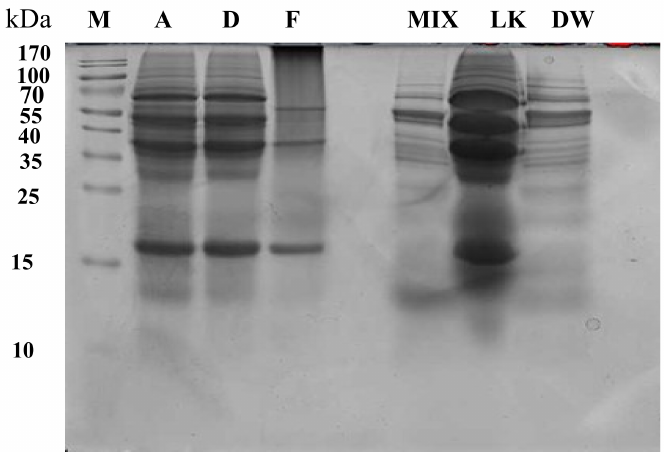
Figure 1. Reduced SDS-PAGE protein profile of lupin-enriched pasta samples and raw materials; M, pre-stained molecular marker; A, D, and F lupin-based pasta samples; Mix, LK: lupin kernel, and DW: durum wheat. Each sample (10 µ L) was added to 10 µ L of loading bu ff er, loading 20 µ L for each